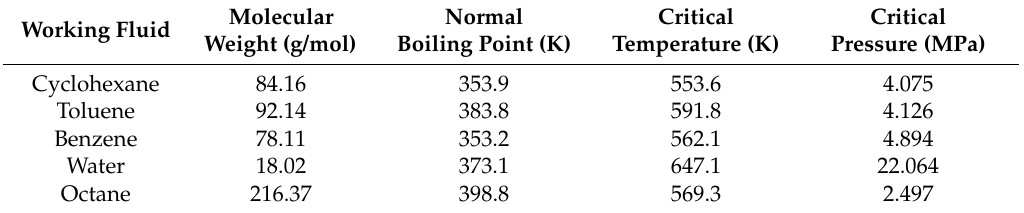
Table 1. Properties of the selected high-temperature working fluid [42].